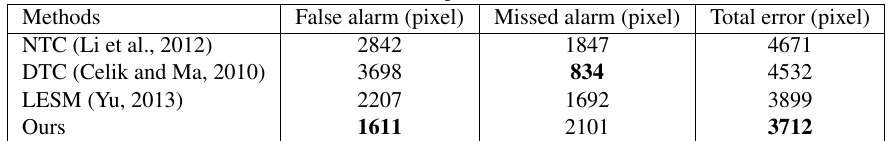
Figure 3: Sardinia dataset Table 1: Quantitative comparison on Mexico dataset